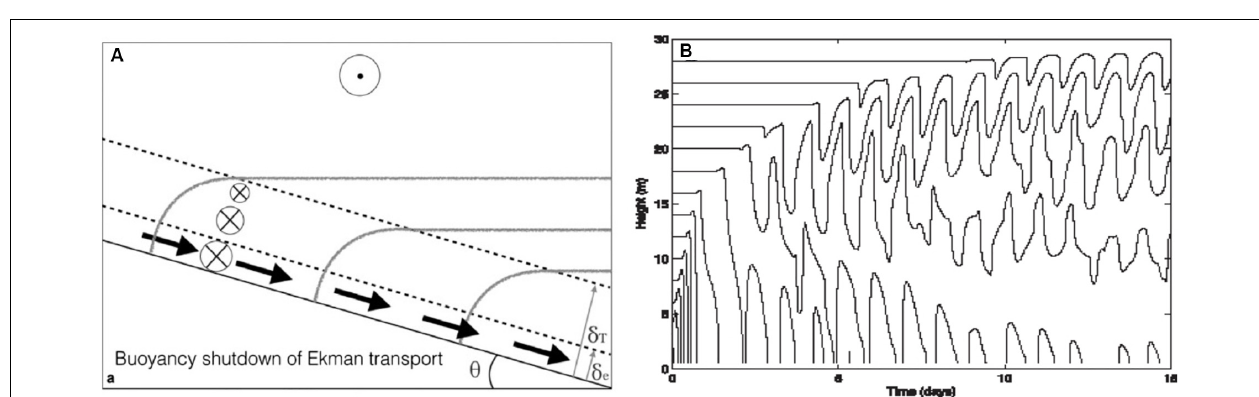
FIGURE 3 | Class #3: mean flows – Ekman layers. The intuition concerning the impact of the viscous bottom boundary condition of no-flow at the boundary comes through rotating into a one-dimensional coordinate system, characterizing the bottom boundary condition via a quadratic drag and solving for a stationary state. Pictured in (A) (from Ruan and Thompson, 2016) is the Ekman layer in its downwelling configuration. This boundary layer system is driven by downslope transports (bold arrows) of light water which results in statically unstable conditions on a height scale δ e over which the quadratic drag projects. These unstable conditions are coupled to internal wave band motions ( B , from Brink and Lentz, 2010a) that parallel the slope and are driven to sufficient amplitude as to mix fluid far above the height scale over which the quadratic drag projects. In (A) , the height scale over which the bottom stress projects is depicted by the lowest dashed line and the height scale over which mixing impacts the near-boundary density field is depicted by the upper dashed line ( δ T ). The direction of the overlying flow is indicated at the top center, solid arrows depict the associated downslope Ekman transport, isopycnals are in gray shading. In (B) , isopycnals are plotted as a function of depth versus time with frequency corresponding to the topographic angle θ in (A) . The steady flow regimes depicted are clearly naive.